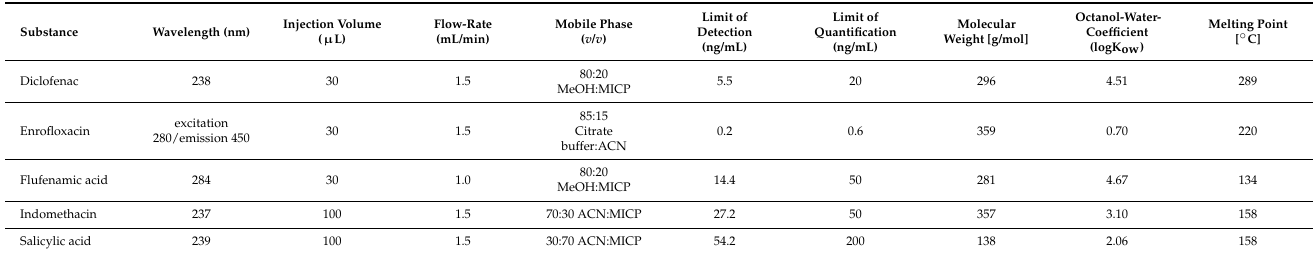
Table 1. Conditions of drug analysis (via HPLC) and physicochemical properties of the drugs; MICP = McIlvaine citrate